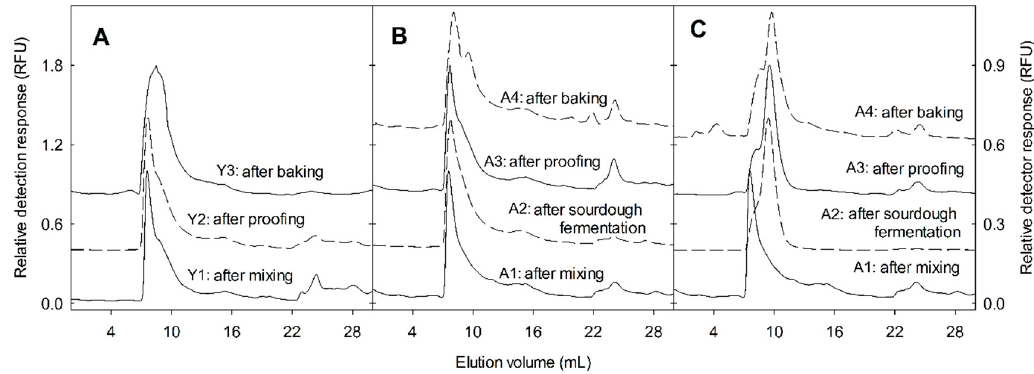
Figure 6. Size-exclusion chromatogram of fluorescein-labelled ATI in bread-making. Panel ( A ): Yeast-fermented bread, Panel ( B ): (III) chemically acidified dough at pH 5.0, Panel ( C ): (V) Rye starter-wheat sourdough. Fluorescence-labelled ATI was added to bread dough Panel ( A ) or to sourdough Panels ( B , C ). ATI was extracted after mixing of sourdough, after sourdough fermentation, or after mixing of bread dough, after proofing, and after baking. FITC-labelled ATI was separated by size exclusion chromatography coupled to a fluorescent detector set at excitation 488 nm and emission 530 nm. Chromatograms were normalized to the highest peak intensity in each chromatogram and were offset by 0.4 RFU. The elution volume of the molecular marker bovine serum albumin (66 kDa) was 7.25 mL, of lysozyme (14 kDa) was 9.86 mL, and of glutathione (307 Da) was 17.35 mL. The Roman number and the sample letters are the same as those indicated in Table 1.